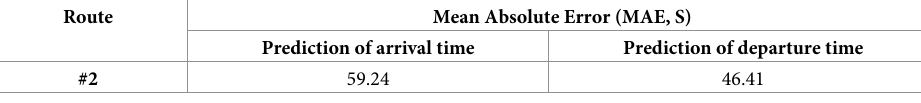
Table 3. The mean absolute error of predictive travel time of route 2 # (entire